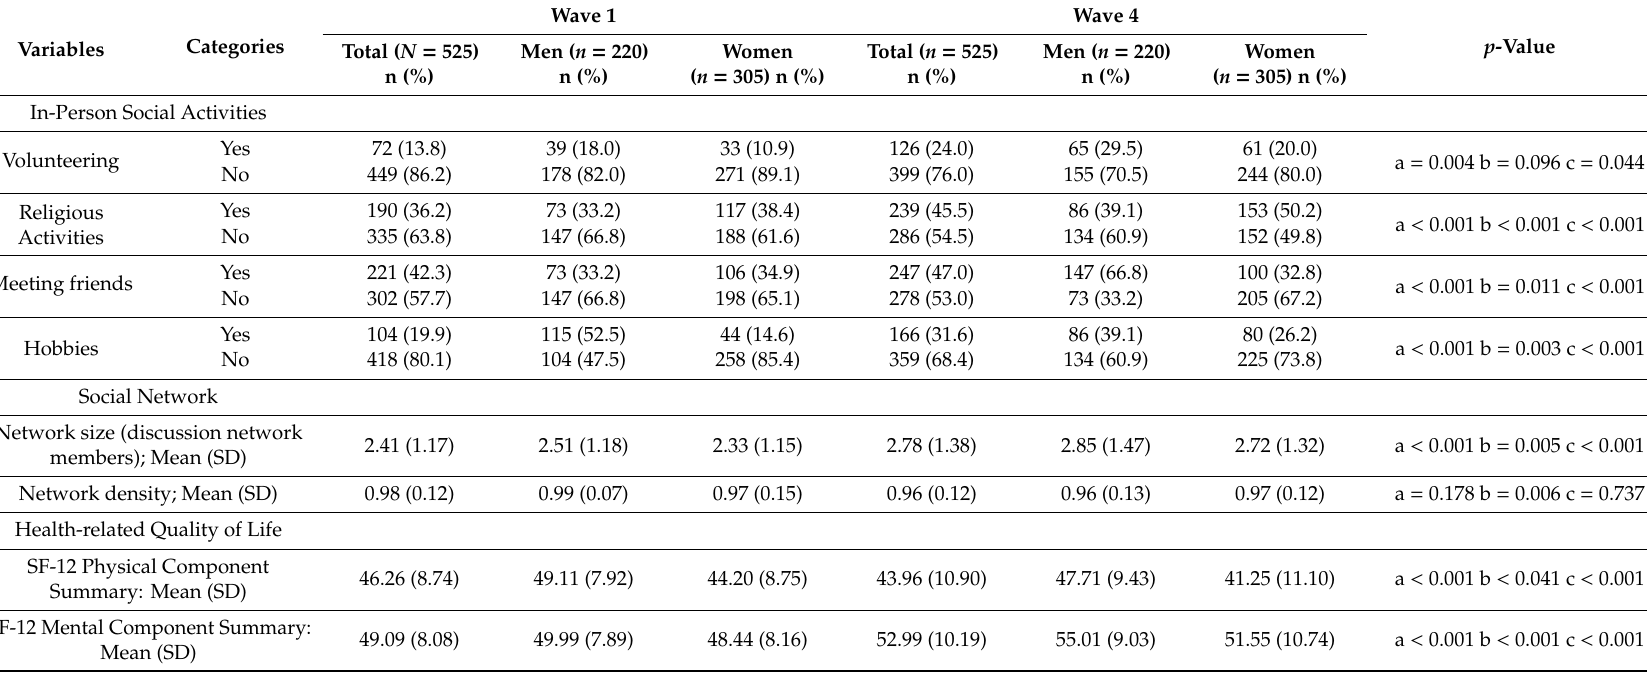
Table 2. Summary of In-Person Social Activities, Social Network, and Health-related Quality of Life from Wave 1 to Wave 4 ( N =